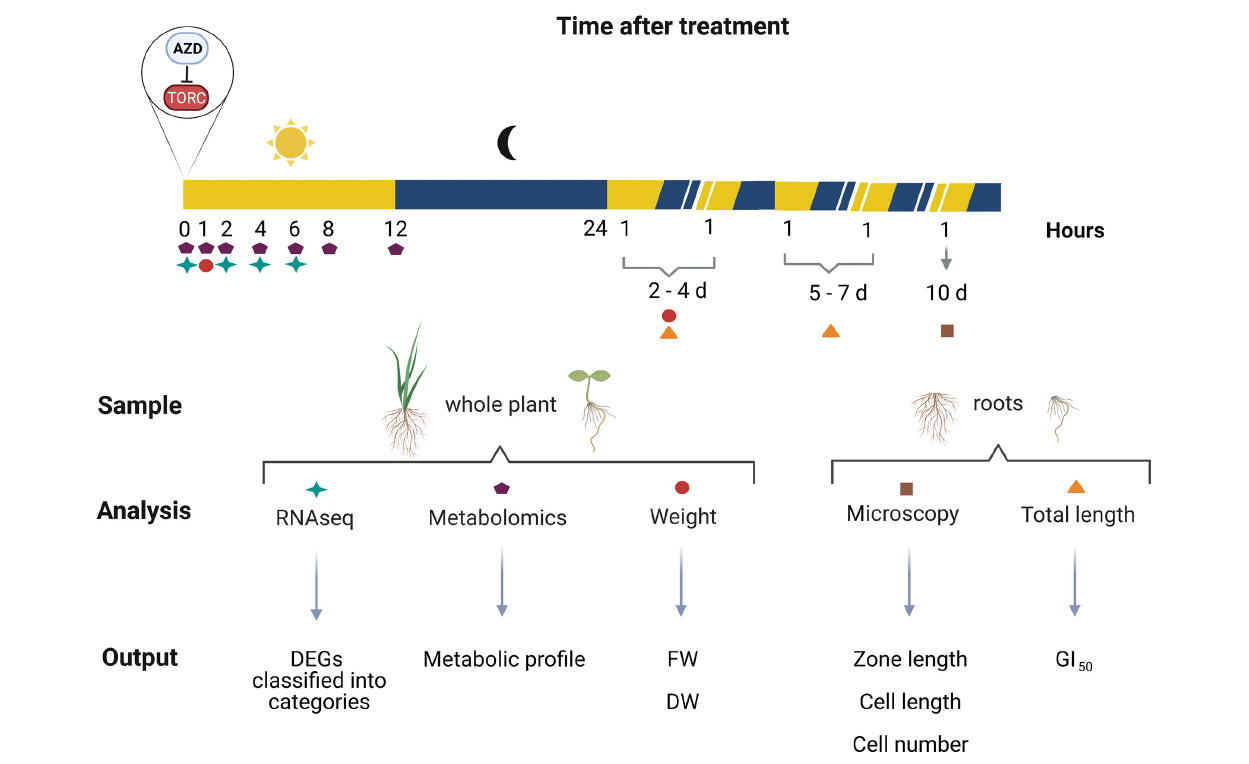
FIGURE 1 | Overview of the experiments performed in this study. Created with